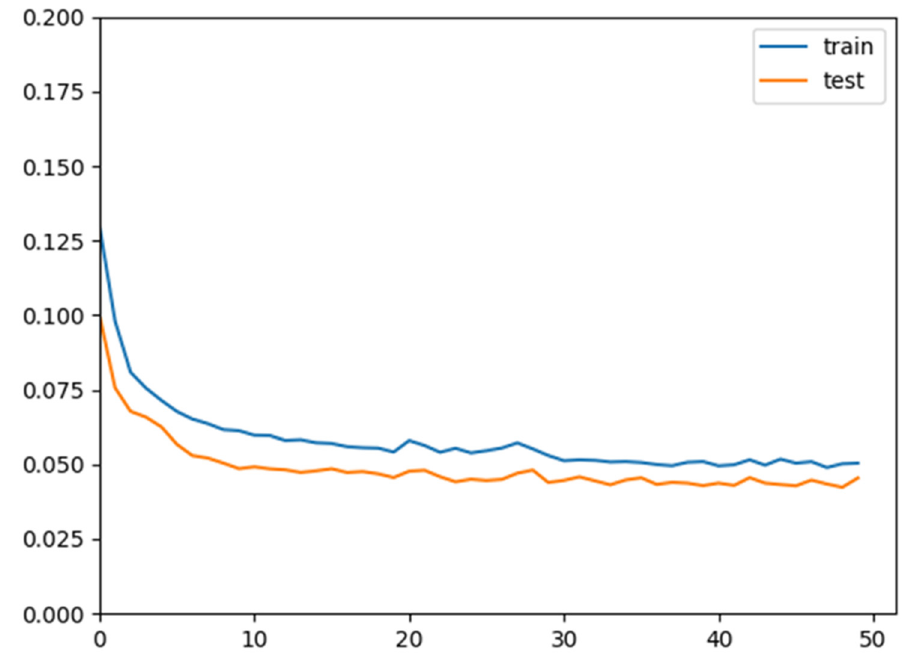
Figure 12. Bee OUT training phase.